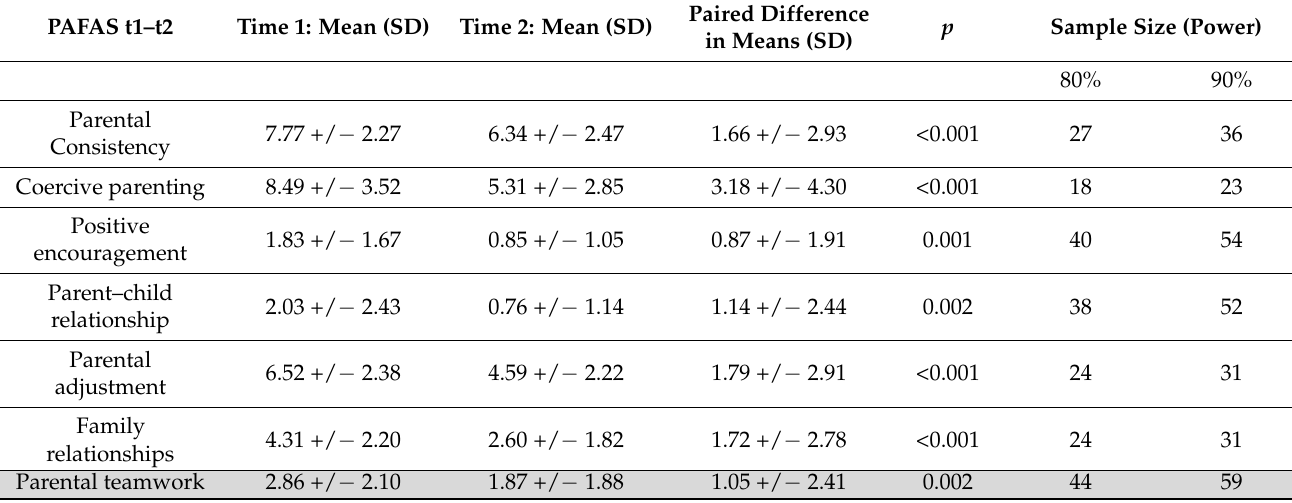
Table A1. Sample size estimates based on PAFAS subscale results from the pilot trial in Afghanistan in autumn 2018 [38,55]. PAFAS